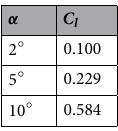
◦ ◦ ◦ ,5 and 10 angles of